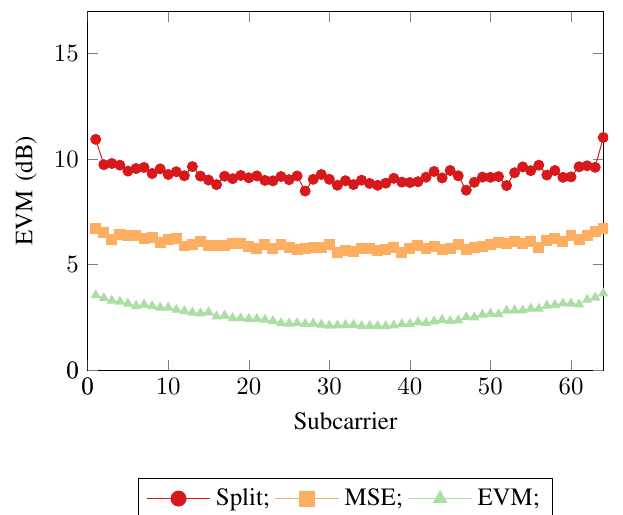
Figure 6. Error Vector Magnitudes across the subcarriers for the 3 neural network receiver approaches for SEFDM with α = 0.8.